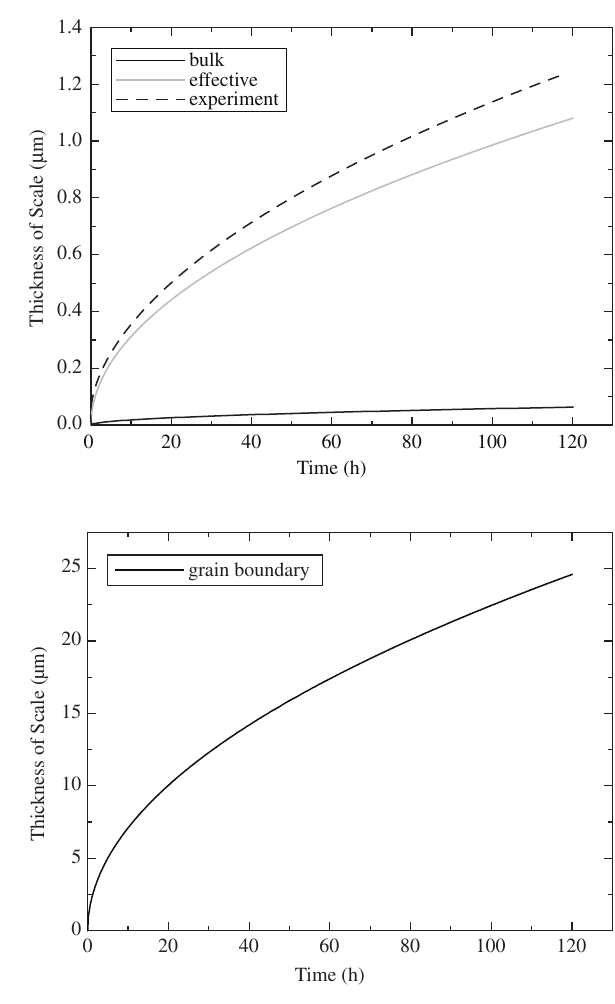
Figure 7. Calculated and measured kinetics of Cr fine-grained specimen at 750 °C during exposure to